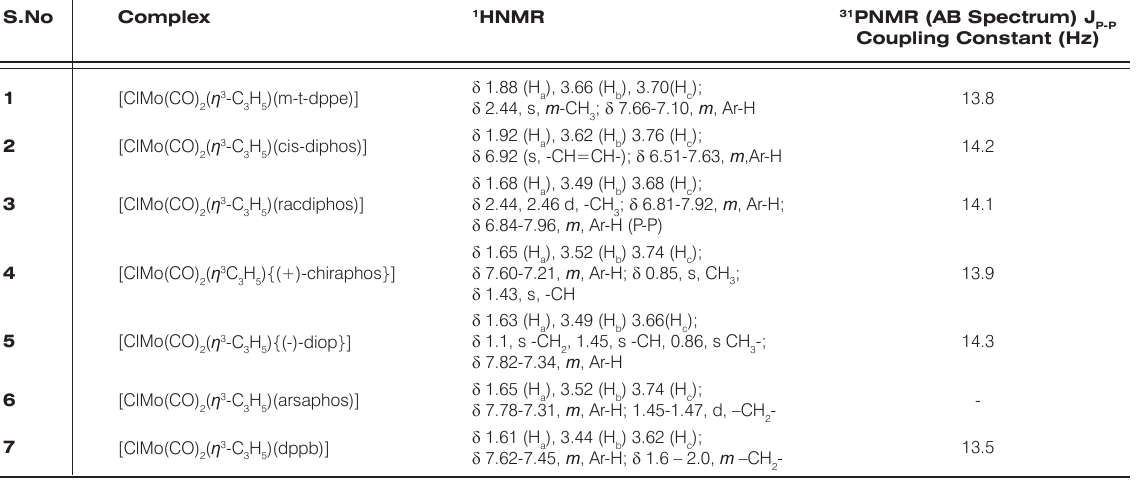
Table 2. 1 HNMR and 31 PNMR data on [ClMo(CO) S.No